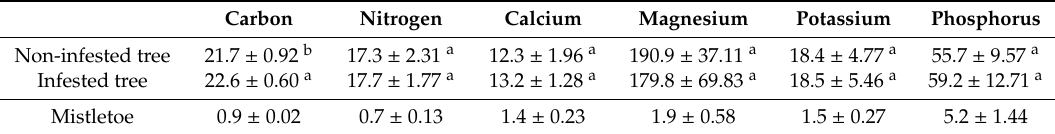
Table 2. Biological absorption coe ffi cient of nutrient (in direction from soil to oaks and from oaks to mistletoe). Mean ± standard deviations are displayed. Superscript letters (a,b) represent the statistical significance at the level of p = 0.05.